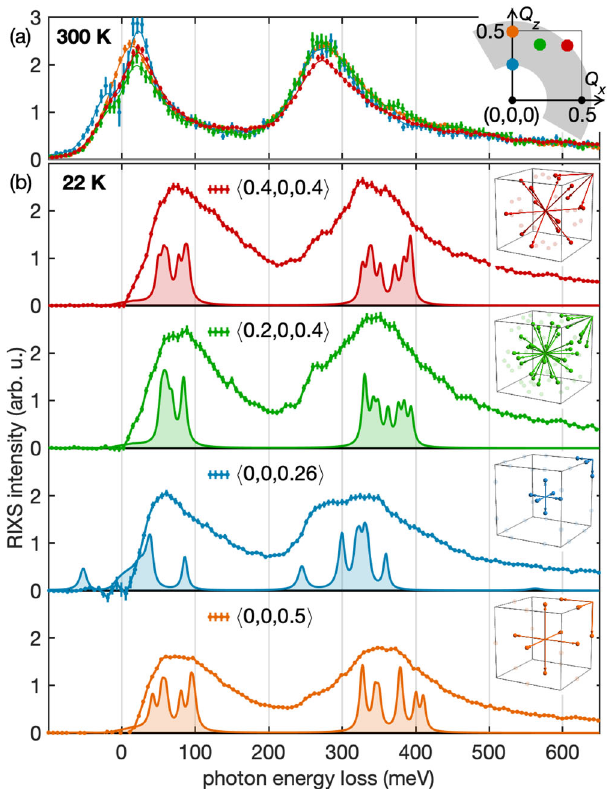
Fig. 3 | Fingerprint of a coherent Kondo lattice state in CePd 3 as observed by resonant inelastic X-ray scattering (RIXS). RIXS spectra are shown at four dif- ferent momentum transfers Q , at a 300K and b 22K. For better comparison, the quasielastic peak has been subtracted. The positions of Q are indicated in the reciprocalspacemapinset,wherethe Q rangeaccessibleto M 5 -edgeRIXSisshaded gray. While at T =300K, well above the coherence temperature T coh ≈ 130K, the signal is almost invariant with regard to Q , for T =22K a pronounced momentum- dependenceemerges.TheinsetviewsofthecubicBrillouinzonein b illustratehow the Q positions probed with RIXS correspond to momentum transfers exciting heavy quasiparticles fromelectronpocketsat Γ and R into unoccupied partsof the electronicstructure. For reference, the shaded spectraineach panel show the DFT +DMFTdensityofstates,asshowninFig.1c,summedovertherelevantpositionsof quasiparticle momentum-transfers in the Brillouin